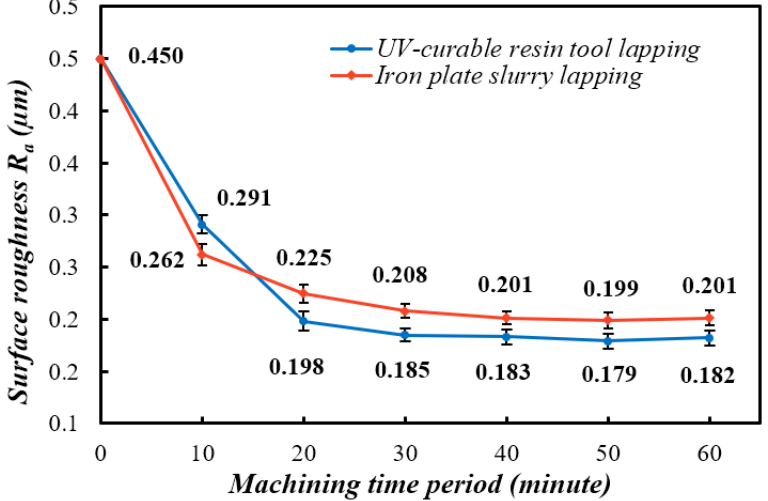
Figure 5. The surface roughness of the ceramic workpiece machined with iron plate lapping and ultraviolet-curable resin